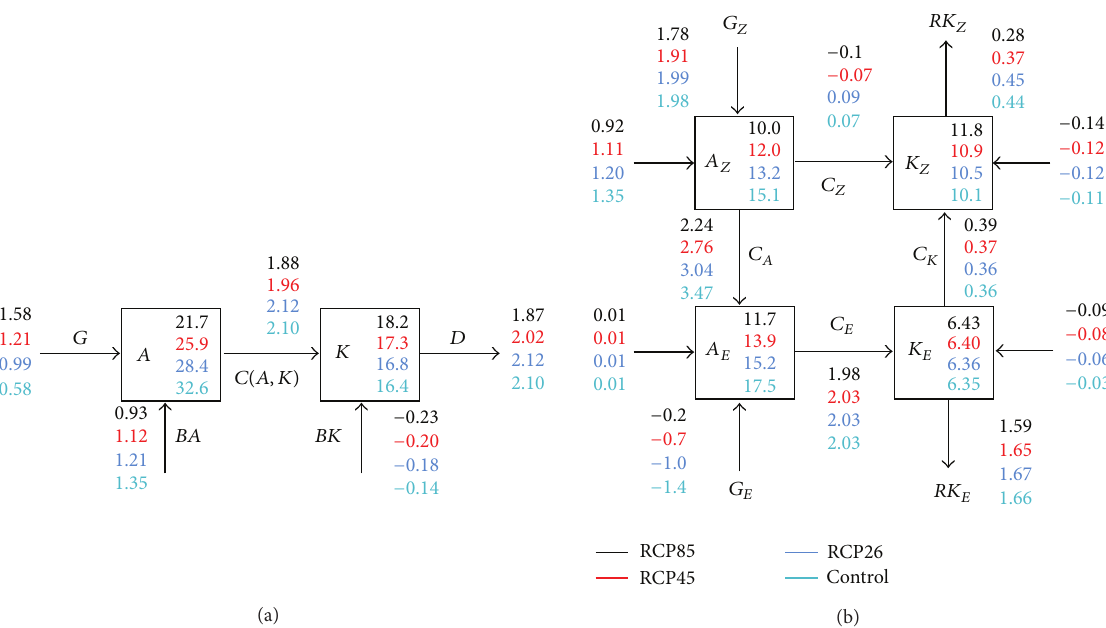
Figure 6: Representation of annual mean of spatial domain Lorenz energy cycle for the Northern Hemisphere in which (a) is representative of a two-component energy cycle and (b) denotes the four-component diagram. The boundaries of available potential energy (𝐵 𝐴 ) and kinetic energy (𝐵 𝐾 ) are included in the two-component energy cycle. Values from up to below in each figure are for RCP85, RCP45, RCP26, and control experiments. Units are 10 5 J/m 2 for reservoirs and W/m 2 for conversion, generation, and dissipation terms. Arrows indicate the direction corresponding to positive values; negative values imply opposite flux